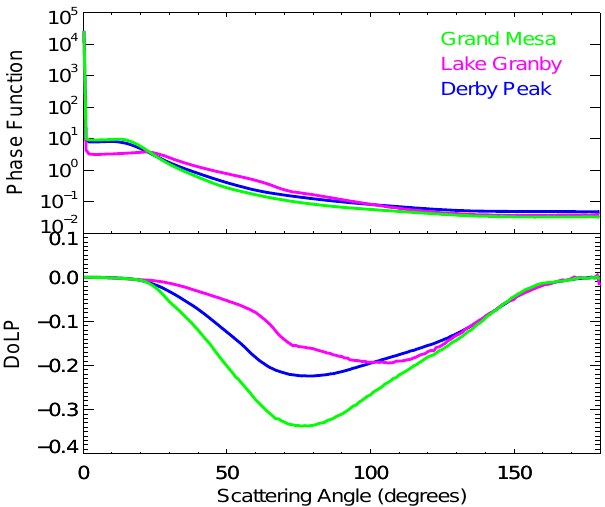
Figure 3. Phase functions (upper panel) and degree of linear po- larization (DoLP, lower panel), resulting from the average over the optimal habits retrieved for each scene. The color coding is the same as for the circles in Fig.